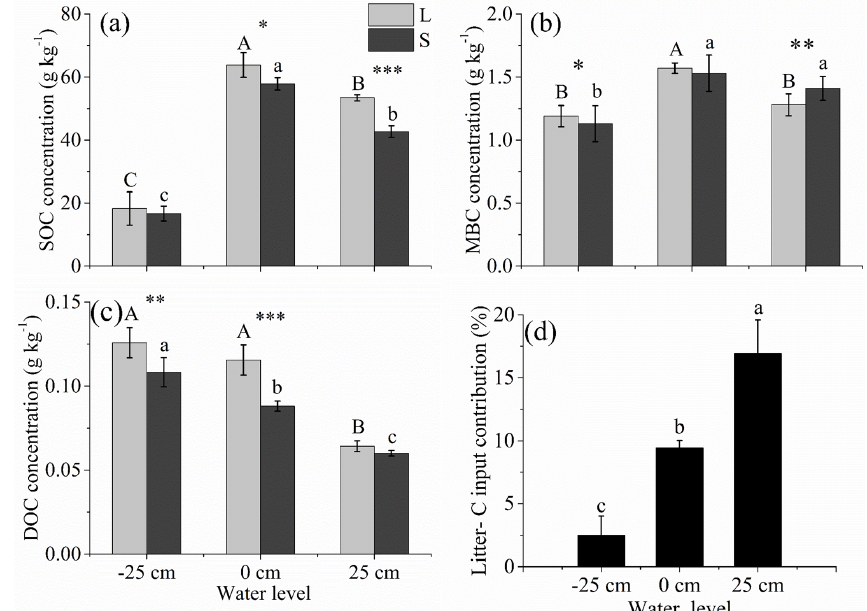
Figure 5. Concentrations of SOC (a) , MBC (b) , DOC (c) between the litter input (L) and litter removal (S) groups and the litter-C input contribution (d) under three water levels at the end of the experiment. Different uppercase letters among vertical bars indicate significant differences among the three water levels in the litter input (L) group. Different lowercase letters indicate significant differences among the three water levels in the litter removal (S) group. The significance level is α = 0 . 05. *, **, and *** represent significant differences between the litter input (L) and litter removal (S) groups at the three water levels at the 0.05, 0.01, and 0.001 significance levels,